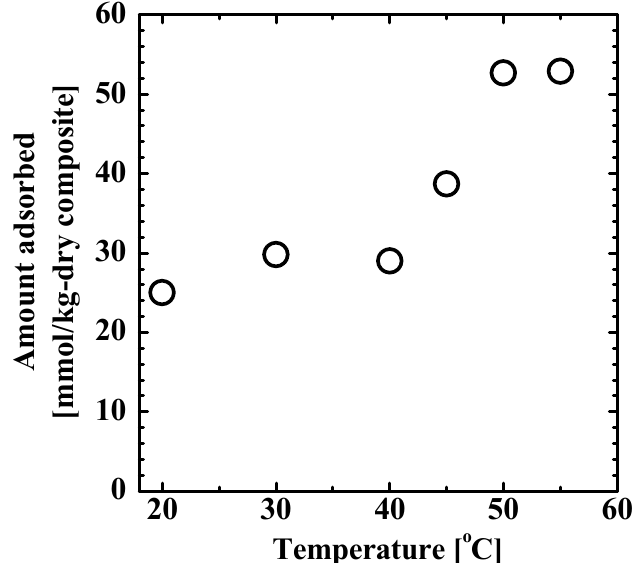
Figure 2. Amount of 4-isopropylphenol adsorbed onto the TiO 2 nanoparticle-loaded fiber as a function of temperature.